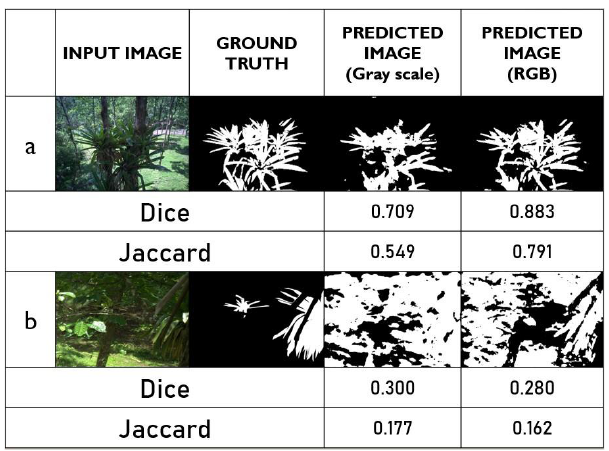
Figure 7: Images that have the target epiphyte under good illumination and high occupancy